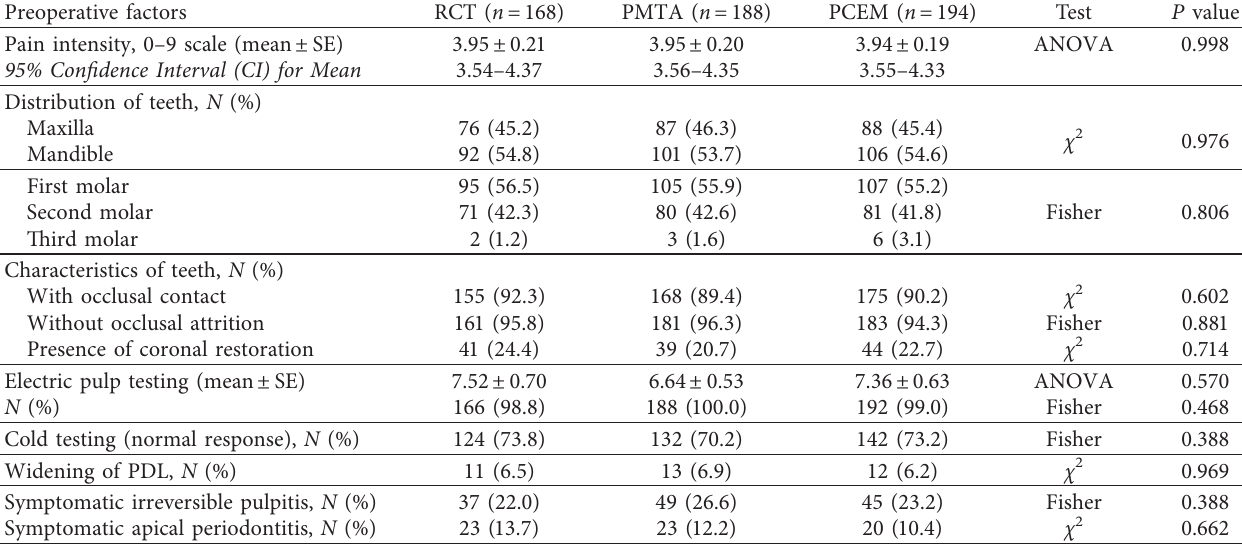
Table 2: Baseline characteristics and preoperative conditions in the three study